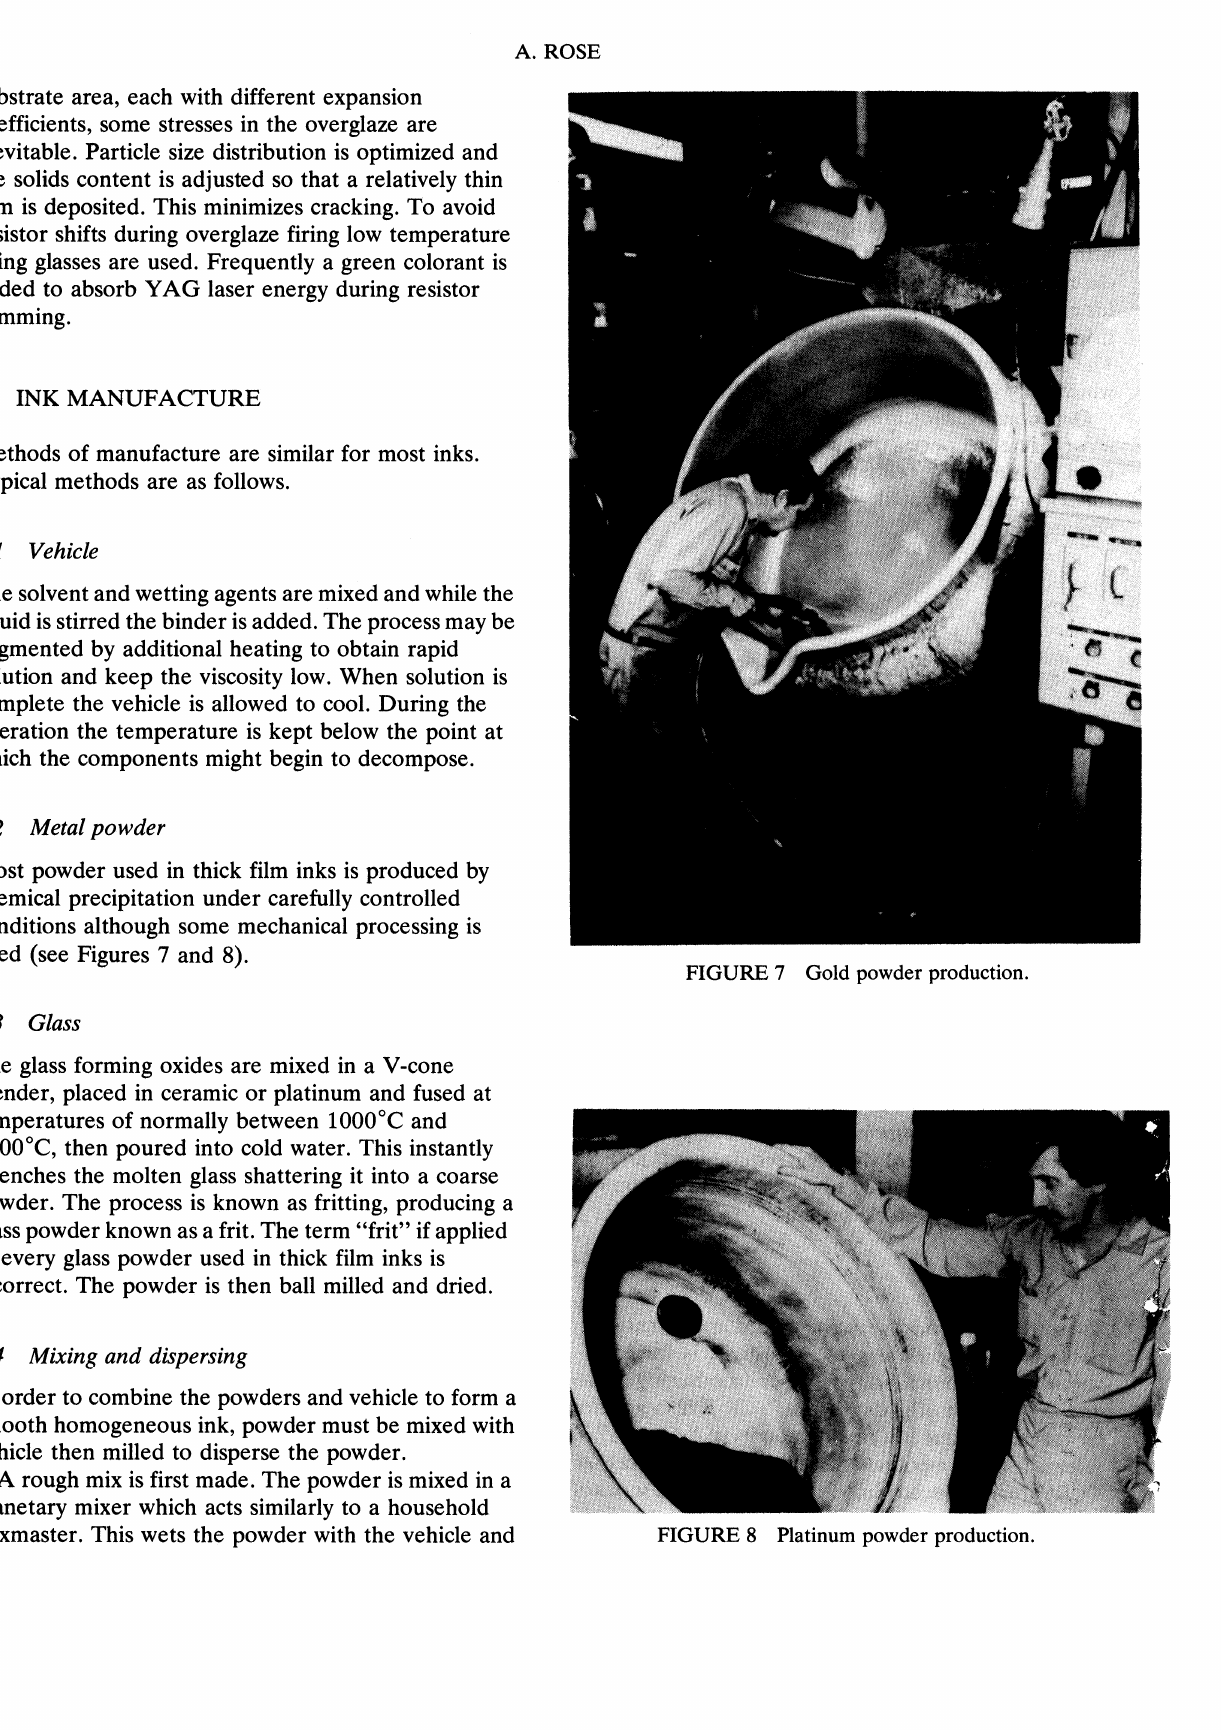
FIGURE 7 Gold powder